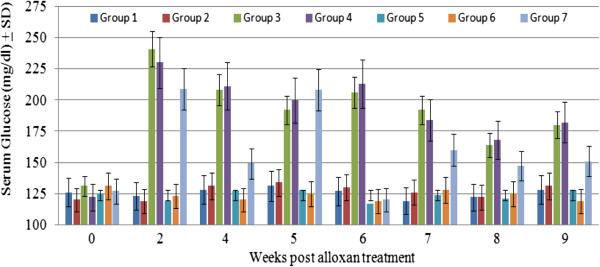
Serum glucose concentration in control and experimental mouse groups at different time points during the experiment. Data presented here is the mean serum glucose in mg/dl ± SD of three separate experiments.